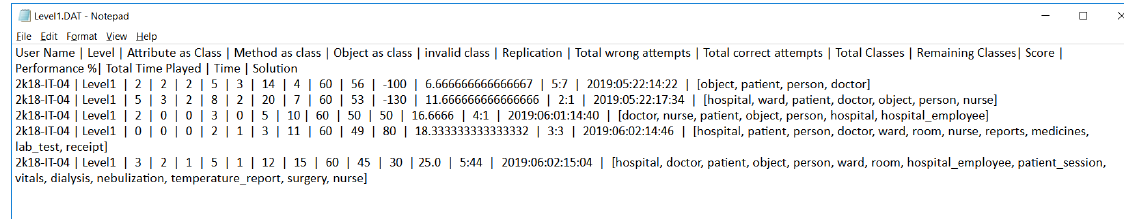
Figure 5. Sample log file generated because of interaction with Level-1. Taken from